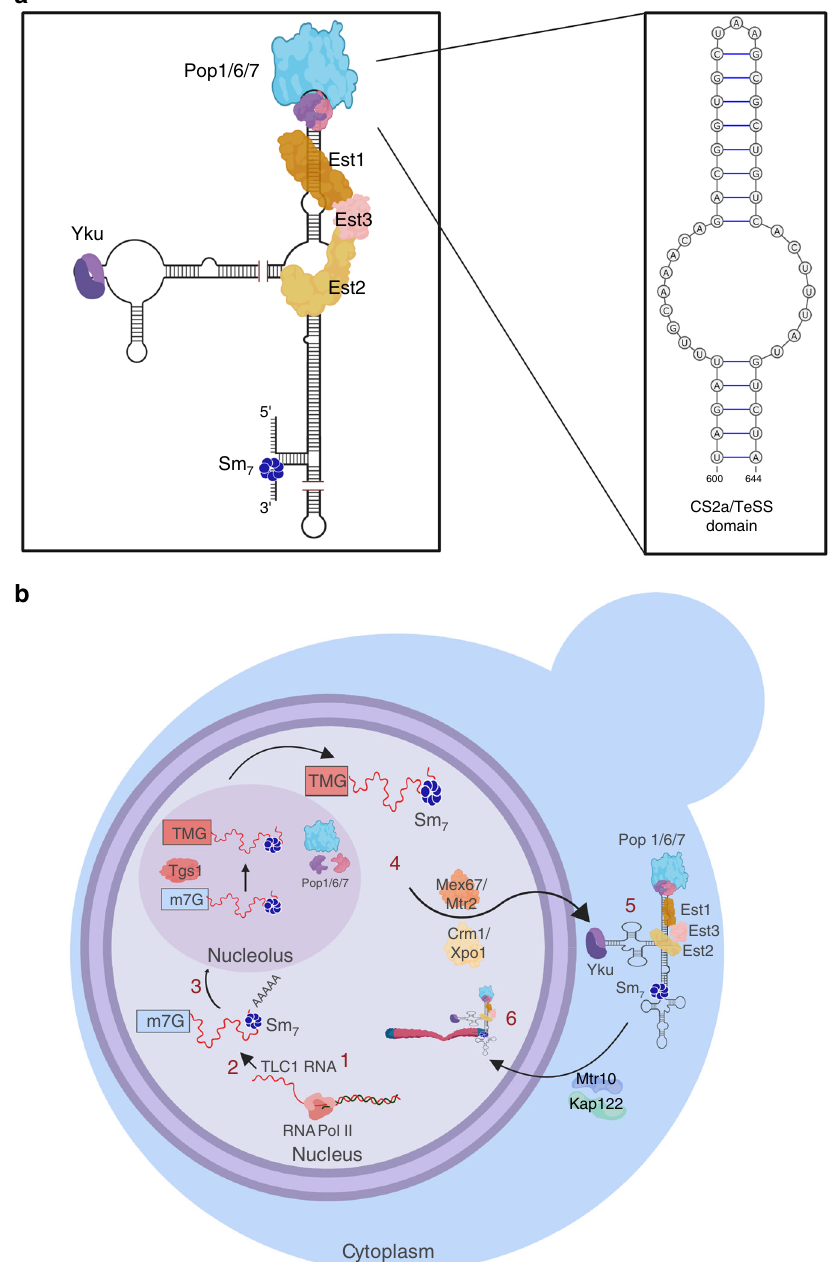
Fig. 1 Structure and biogenesis of TLC1. a Est1 and Pop proteins bind at separable sites near the end of the Est1 arm of TLC1. Est3 interacts directly with Est1 and Est2, possibly bridging the two, and both of these associations are required for Est3 to bind telomeres. Est2 binds the central core of TLC1. (The proteins and RNA are not drawn to scale; 1a is a static representation meant to illustrate the sites on TLC1 to which the indicated proteins bind and the protein-protein interactions amongst the telomerase subunits.) The binding sites for the heterodimeric Ku complex and the Sm7 complex are also shown. Insert shows magni fi ed view of the CS2a/TeSS domain to which a Pop6/7 heterodimer binds and then recruits Pop1 22 . b Biogenesis of TLC1: (1) TLC1 is transcribed in the nucleus by RNA polymerase II. (2) The newly transcribed TLC1 has a 5 ′ -7 methylguanosine cap, is bound by the Sm7 complex which helps stabilize the RNA 11 and a fraction of molecules have a poly(A) 3 ′ tail. (3) TLC1 transits to the nucleolus where the 5 ′ cap gets hypermethylated by the Tgs1 methyltransferase. (4) TLC1 is bound by the indicated export factors that bring it to the cytoplasm. (5) TLC1 lacking a poly(A) tail assembles with the Est proteins in the cytoplasm. (6) In G1 phase, when Est1 abundance is low, Est1 and Est3 are not TLC1-associated. However, a Yku-TLC1-Est2 complex forms and is telomere associated in G1 phase. In late S/G2 phase, the holoenzyme forms in the cytoplasm and binds import factors Mtr10/Kap122 that mediate holoenzyme entry into the nucleus. The holoenzyme binds and elongates telomeres. Pop proteins are present in the nucleoplasm, nucleolus, and cytoplasm. The compartment in which Pop proteins bind TLC1 is not known. However, Pop proteins are TLC1-associated in both G1 and G2/M phase (see text for references). Images were made in BioRender